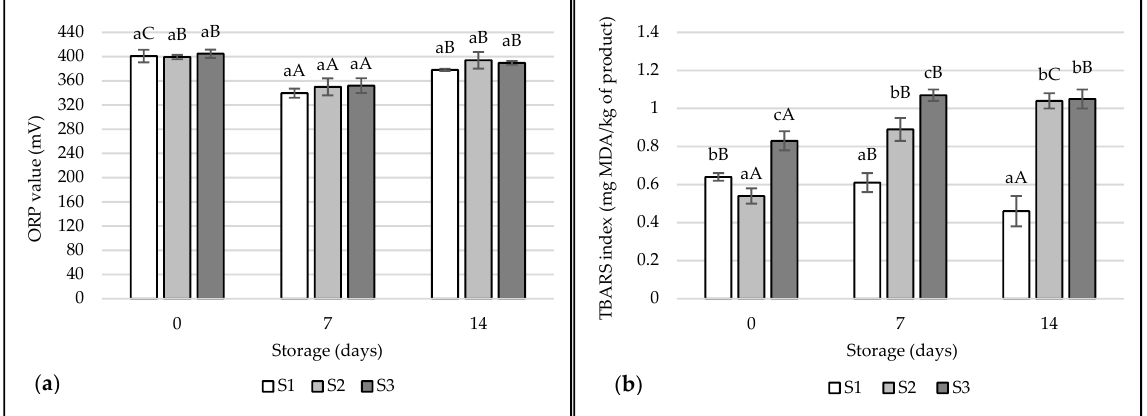
Figure 3. Oxidation-reduction potential (ORP) ( a ) and TBARS index ( b ) of the tested samples of pork hams. The values are expressed as means ± SD. Values marked with lowercase letters (a–c) differ significantly between treatments. Values marked with capital letters (A–C) differ significantly between storage times.